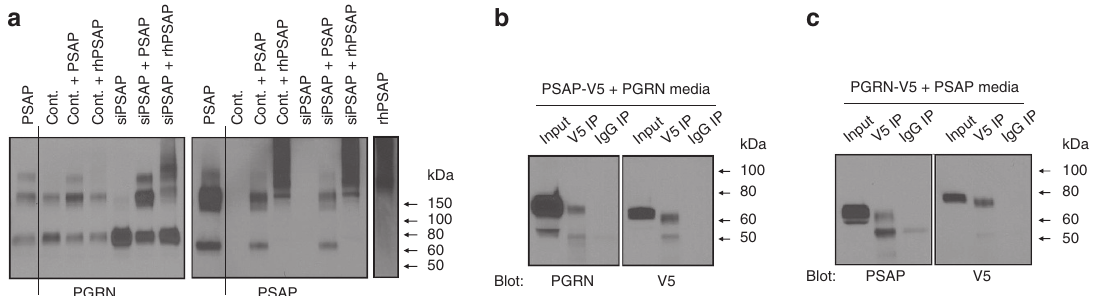
Figure 9 | Extracellular PSAP might directly interact with extracellular PGRN. ( a ) Immunoblot of crosslinked conditioned media from HeLa cells transfected with PSAP plasmid (PSAP), control siRNA (Cont.) or PSAP siRNA (siPSAP) mixed together or with rhPSAP. ( b , c ) Co-IP assays of conditioned media harvested from HeLa cells co-transfected with PSAP-V5 and untagged PGRN plasmids ( b ) or with PGRN-V5 and untagged PSAP plasmids ( c